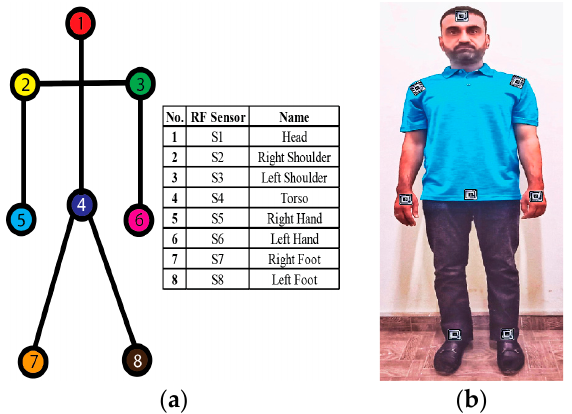
Figure 5. ( a ) Targeted RF points ( b ) RFID tag deployment on subject.